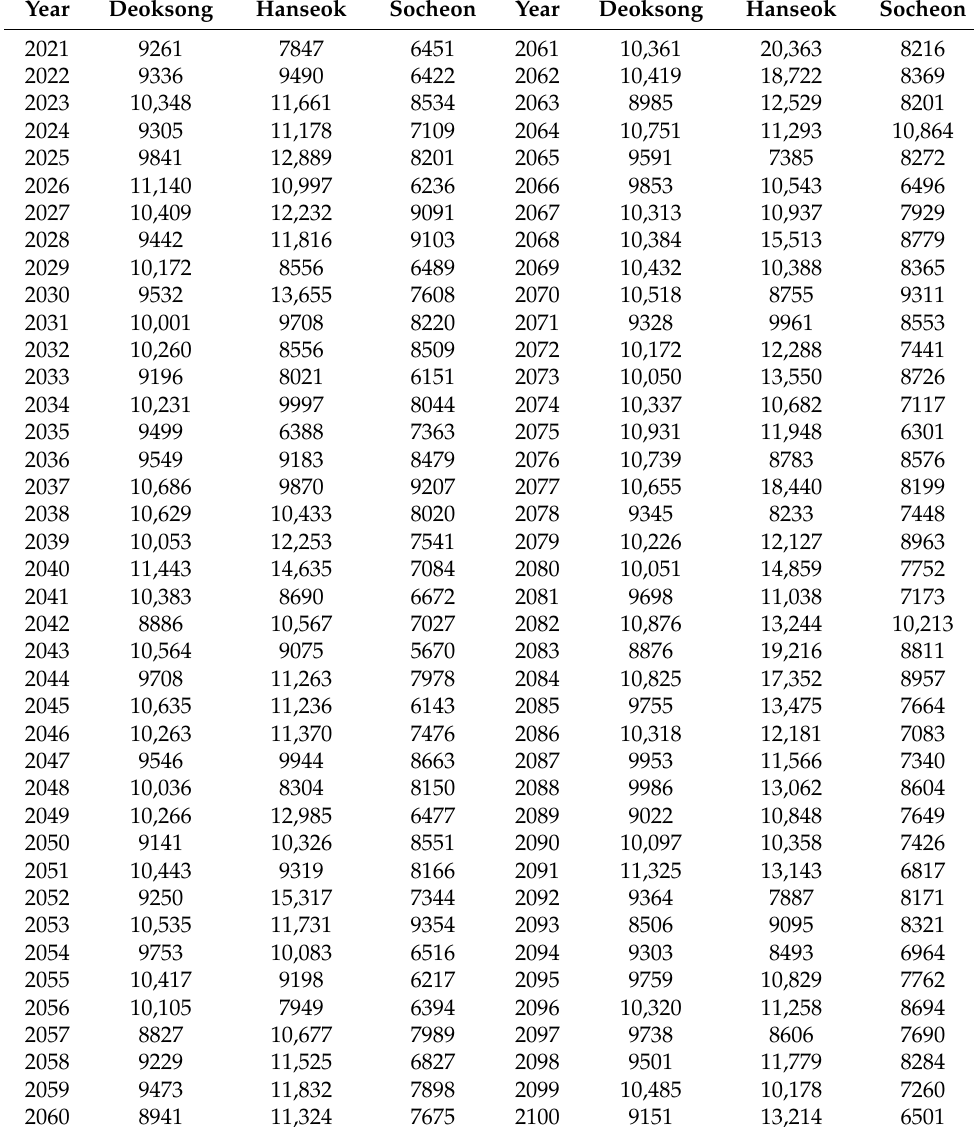
Table 8. Estimated annual SHP potential by SHP plant (2021–2100) [unit: